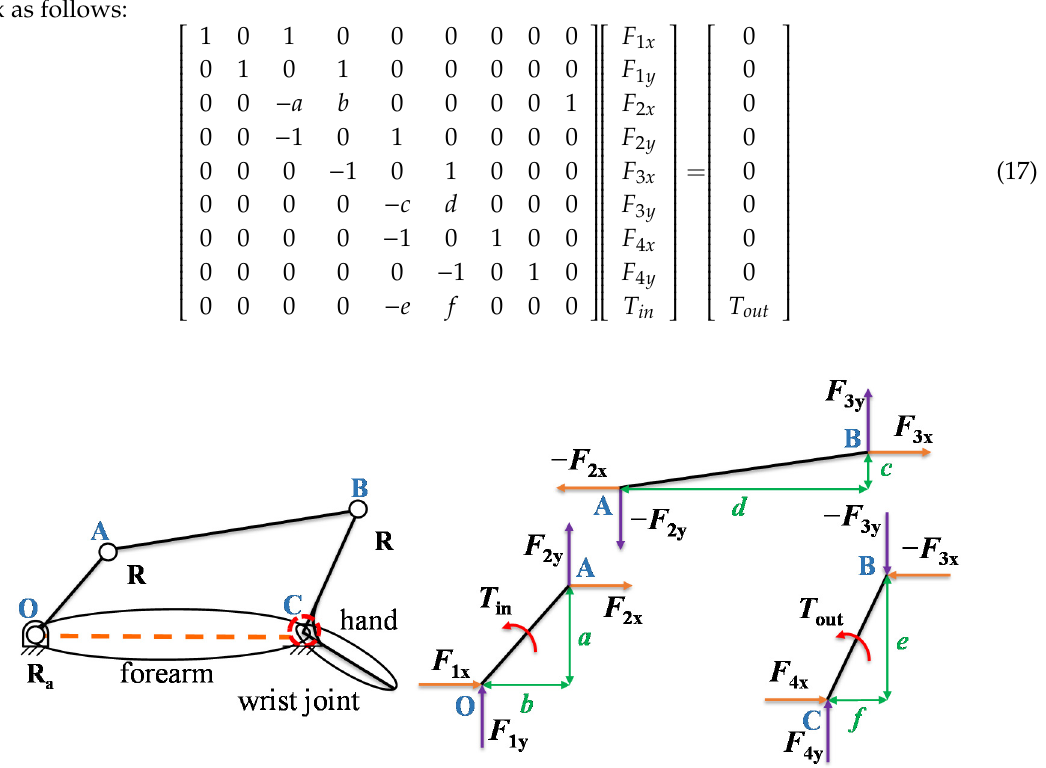
Figure 7. Free body diagram of four-bar linkage.